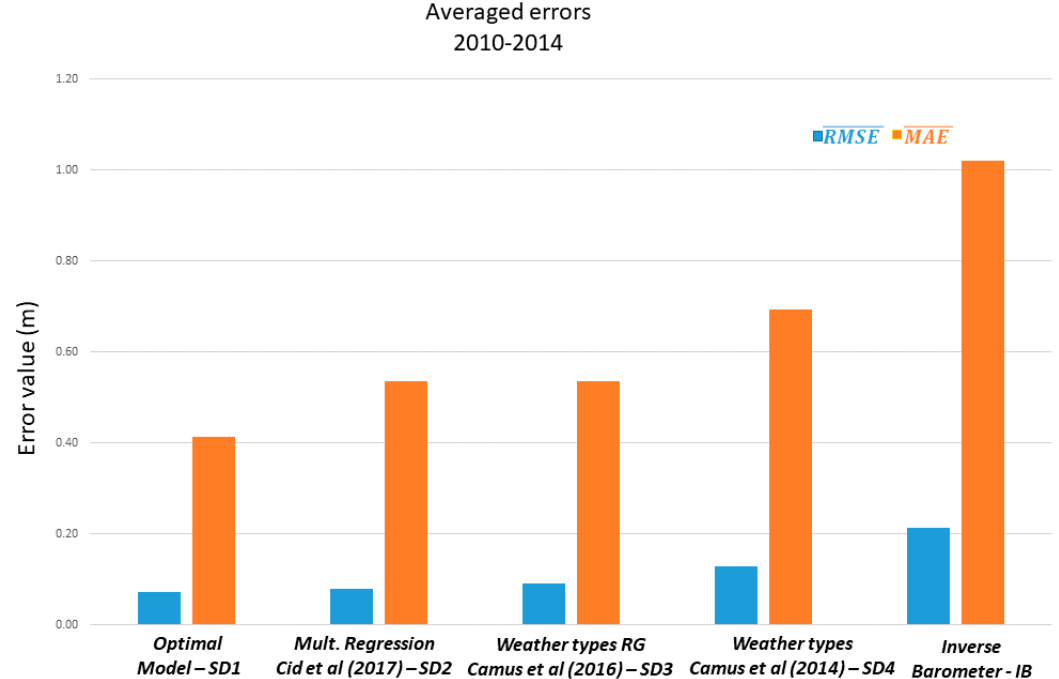
Figure 5. Average error values ( RMSE and MAE ) for validation years 2010 to Figure 5. Average error values ( 𝑅𝑀𝑆𝐸(cid:3364)(cid:3364)(cid:3364)(cid:3364)(cid:3364)(cid:3364)(cid:3364)(cid:3364) and 𝑀𝐴𝐸(cid:3364)(cid:3364)(cid:3364)(cid:3364)(cid:3364)(cid:3364)(cid:3364) ) for validation years 2010 to 2014.